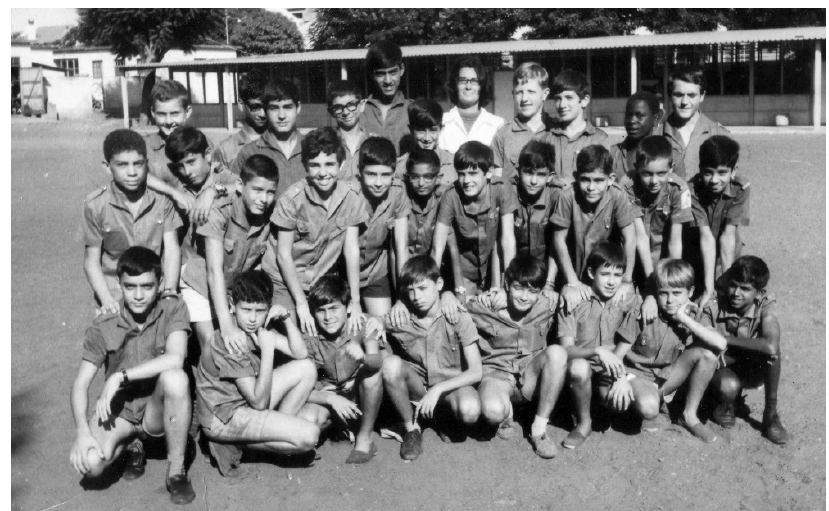
Figure 3. Maria Carlota Quintanilha with her pupils, Gen. José Machado Preparatory School. Lourenço Marques (now Maputo), Mozambique, 1960s. (Credits and courtesy: Luís Lage archive).